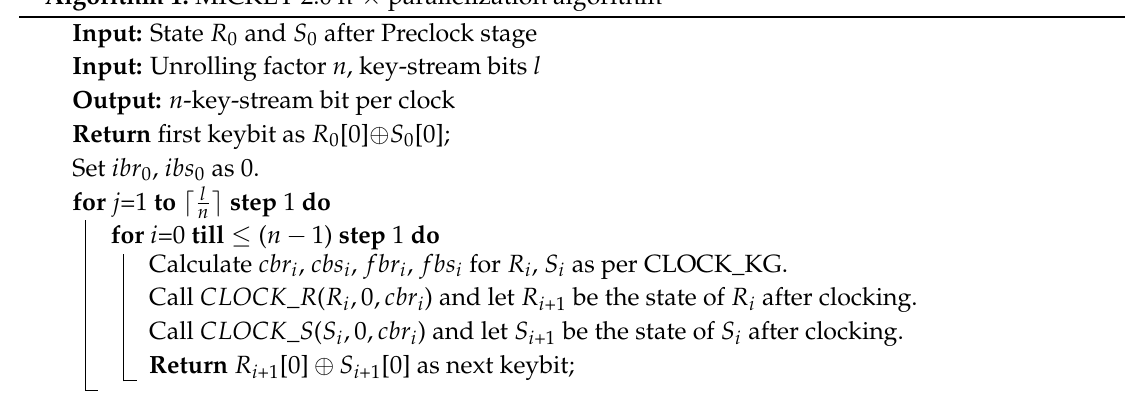
Algorithm 1: MICKEY 2.0 n- × parallelization